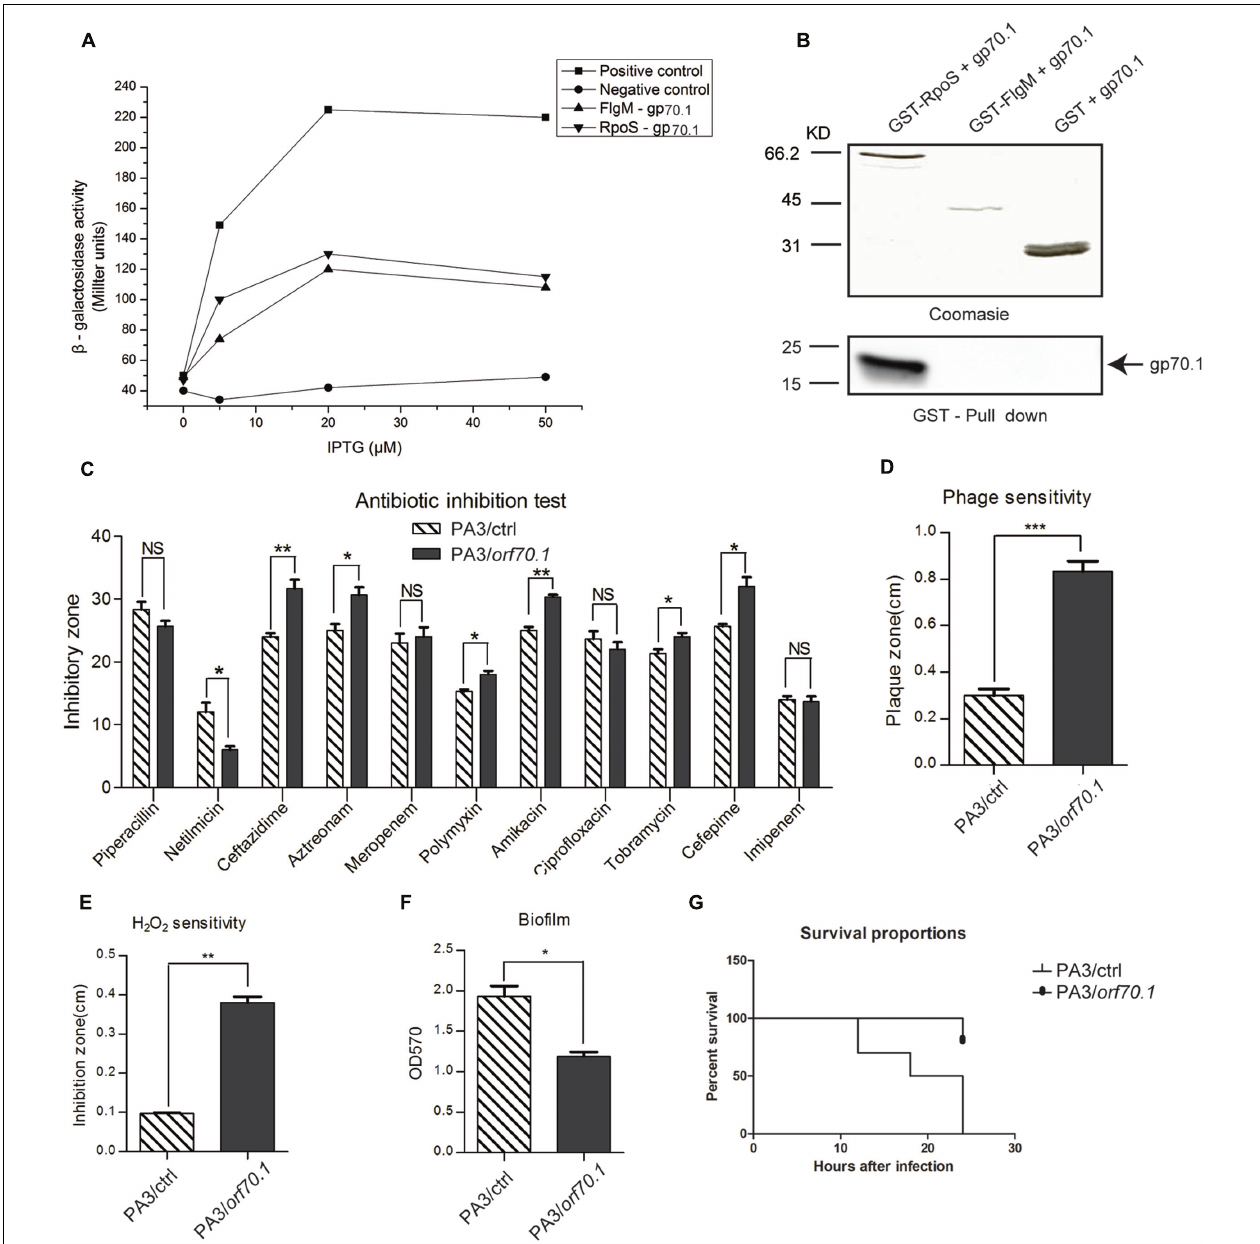
FIGURE 8 | Identification of the target protein of gp70.1. (A) Bacterial two-hybrid assay was used to screen target proteins of gp70.1 in PA3, showing FlgM and RpoS the potential targets of gp70.1. (B) Confirmation of the FlgM-gp70.1 and RpoS-gp70.1 interactions by GST Pull-down. (C–G) Evaluation for the influence of gp70.1 on the typical biological function regulated by RpoS. The statistical significance of changes in expression was assessed by paired t -test ( ∗ p < 0.05; ∗∗ p < 0.001; ∗∗∗ p < 0.0001).